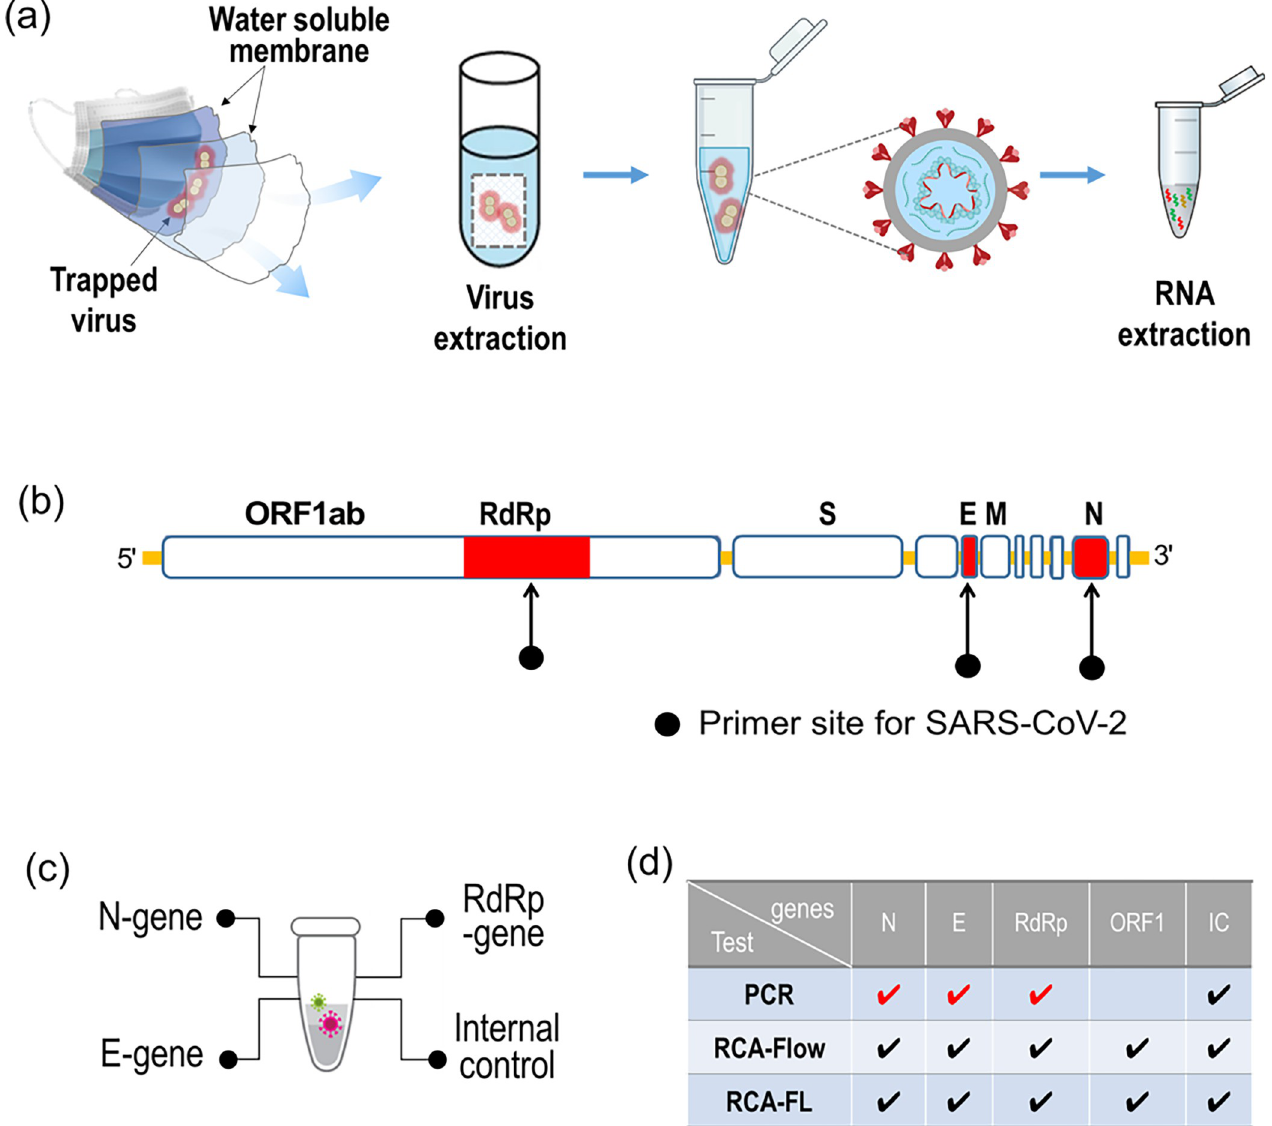
Fig 1. ( A) Process of viral RNA extraction from a mask in exhalation including virus collection with a mask from exhaled breath, extraction of virus from mask membranes, isolation of viruses; and extraction of viral RNA; ( B) Primer sites to identify SARS-CoV-2; ( C) SARS-CoV-2 target genes extracted from mask; ( D) List of target genes for three different assays including PCR, RCA-Flow and